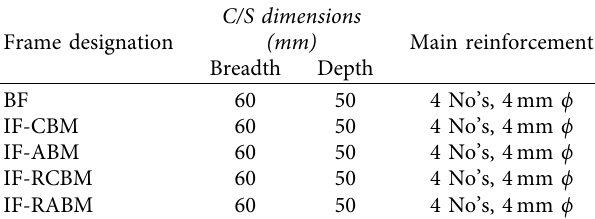
Table 1: Dimension details of